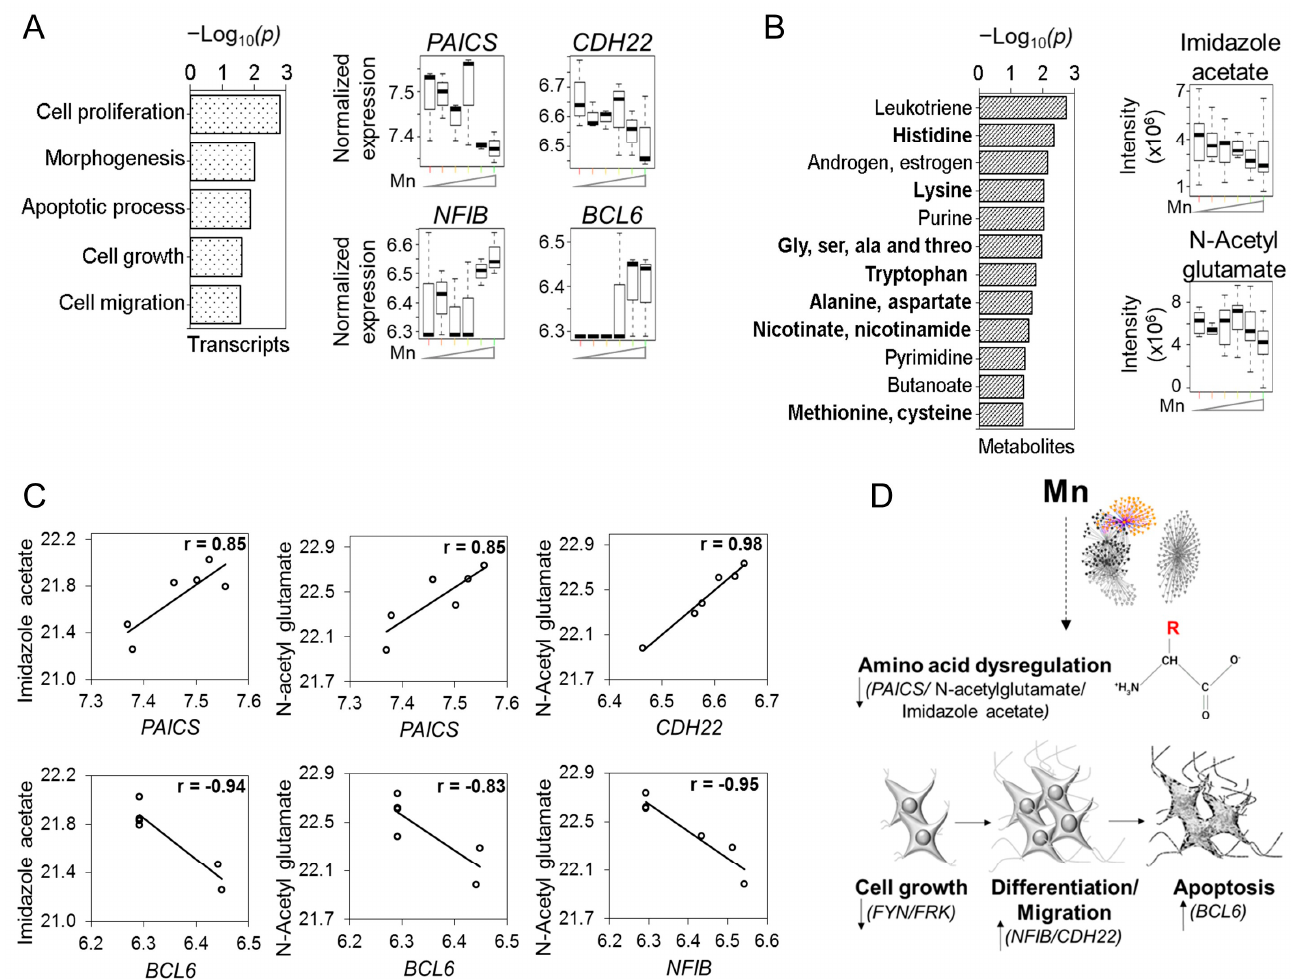
Figure 2. Community 1: environmental stressor subnetwork associated with signaling markers for biosynthesis, morphogenesis, amino acid metabolism, di ff erentiation and apoptosis. Pathway enrichment analysis of genes and metabolites associated with cellular Mn subnetwork were studied. ( A ) Top pathways enriched by Mn-dependent genes at p < 0.05, represented as − log 10 (p) Expression of Mn-dependent individual genes from these enriched pathways presented as boxplots include genes involved in amino acid metabolism—PAICS; morphogenesis—CDH22; di ff erentiation—NFIB and apoptosis—BCL6. (B) Mn-dependent metabolites enriched in amino acid and energy related pathways (bold) at p < 0.05 depicted as − log 10 (p). Raw intensity of individual metabolites from these enriched pathways presented as boxplots include amino acid metabolites—imidazole acetate and N-acetyl glutamate. ( C ) Antagonistic interactions of genes and metabolites in cellular Mn-depend- ent cluster. ( D ) Schematic illustrating cellular Mn-associated key drivers of cell growth, di ff erentia- tion, migration and apoptosis through amino acid dysregulation. Detailed information on genes and metabolites from Community 1 provided in Tables S1, S2 and S9. |r| > 0.8, p < 0.05.